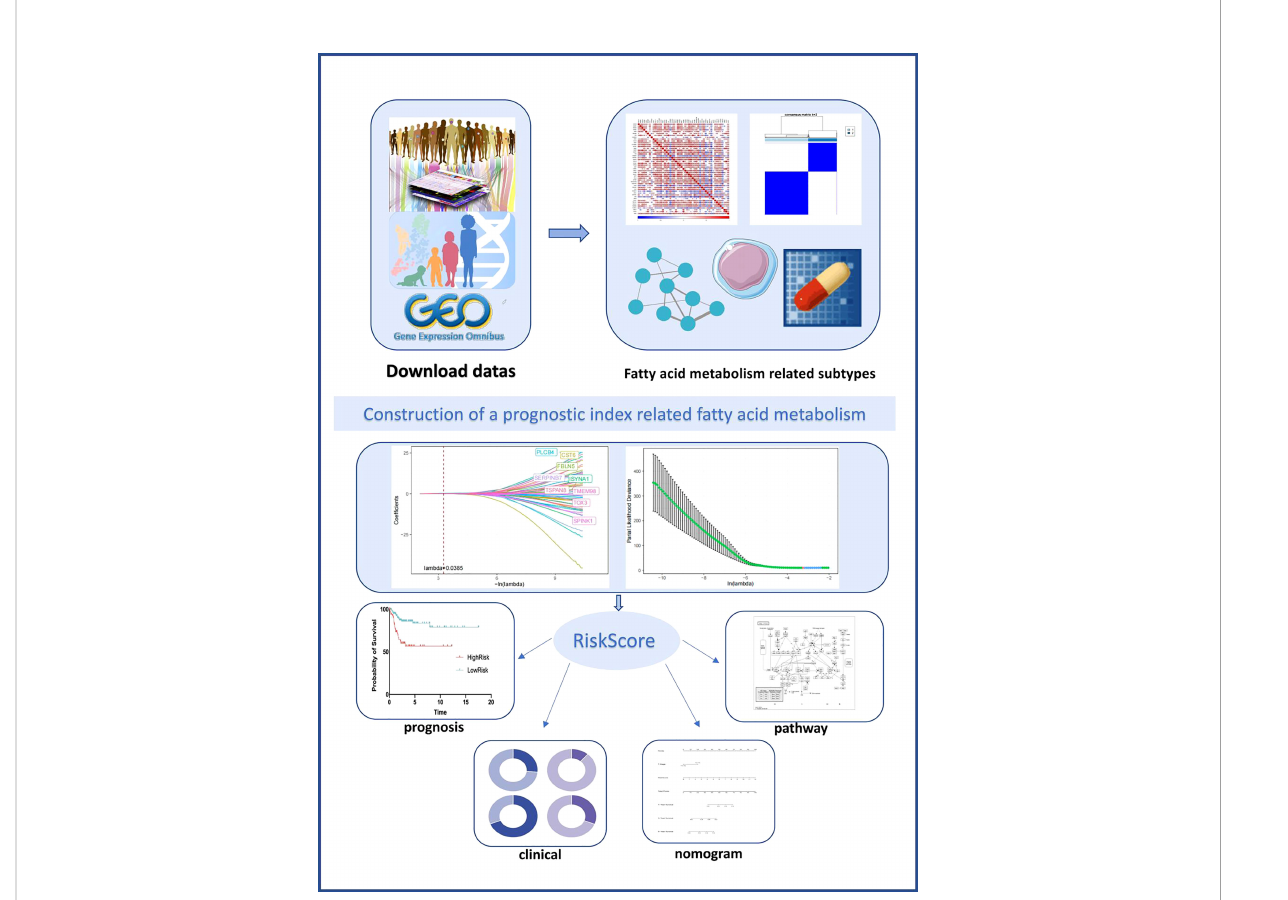
FIGURE 1 Graphical abstract of the construction of a prognostic index associated with fatty acid metabolism in cervical cancer.